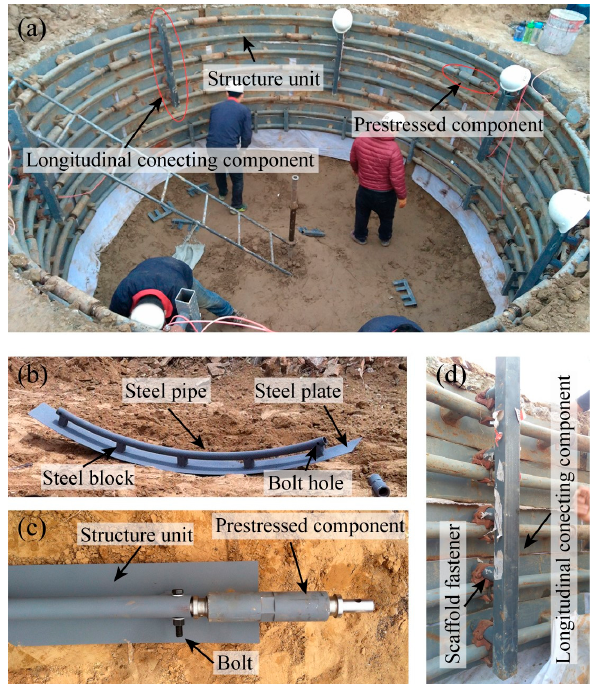
Figure 2. Physical map of the prestressed supporting structure: ( a ) Construction picture of the prefabricated supporting structure; ( b ) the structure unit shown in ( a ); ( c ) connection of the structure unit and prestressed component; and ( d ) connection of the structure unit and longitudinal connecting component.